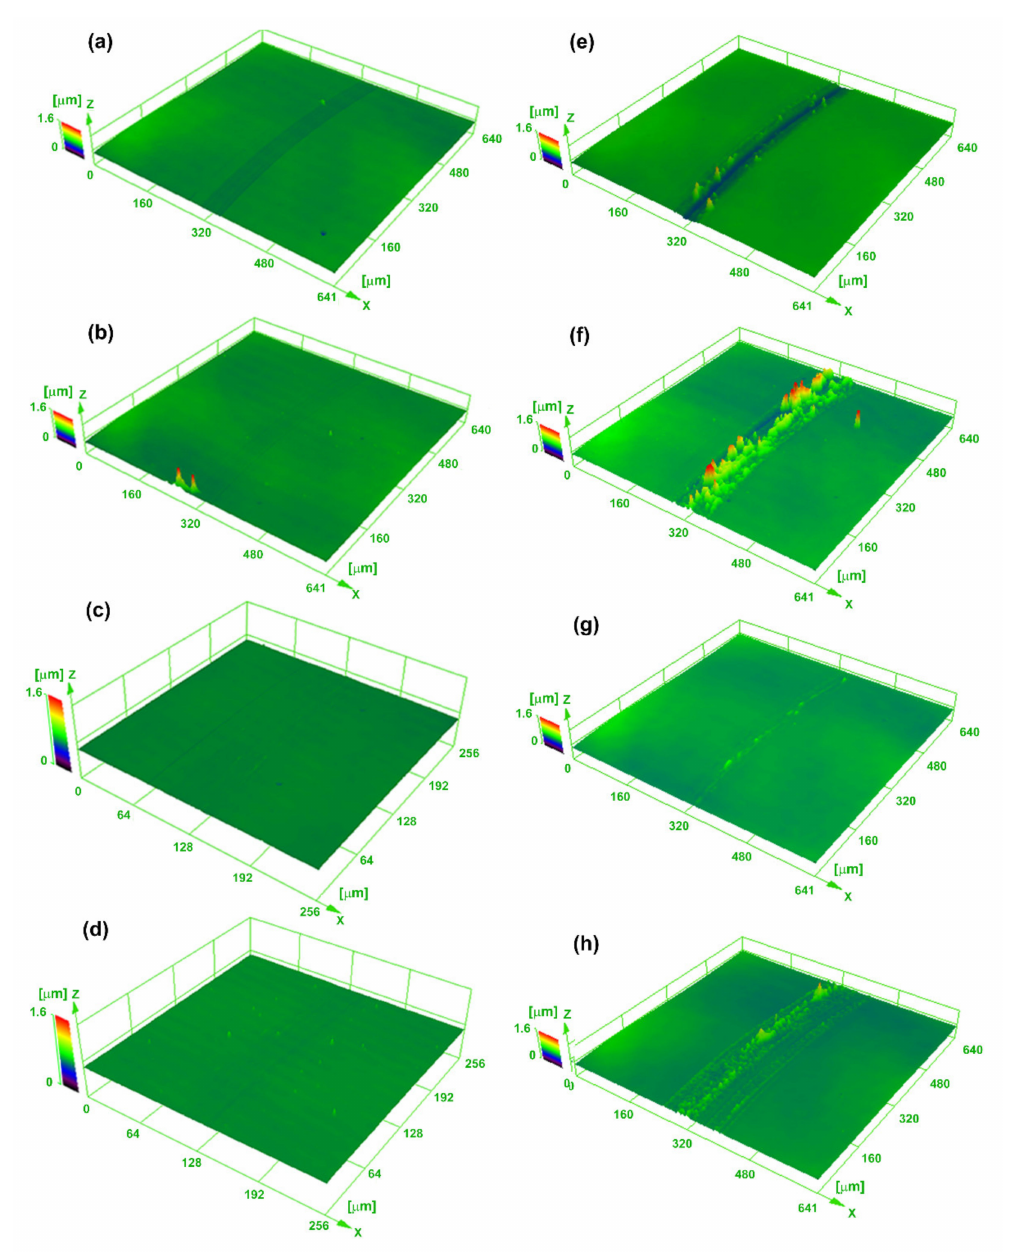
Figure 8. 3D morphologies of the wear tracks after ( a – d ) 60 cycles and ( e – h ) 300 cycles on the TaN x coatings deposited at ( a ) and ( e ) 0 V, ( b ) and ( f ) − 100 V, ( c , g ) − 200 V and ( d , h ) − 300